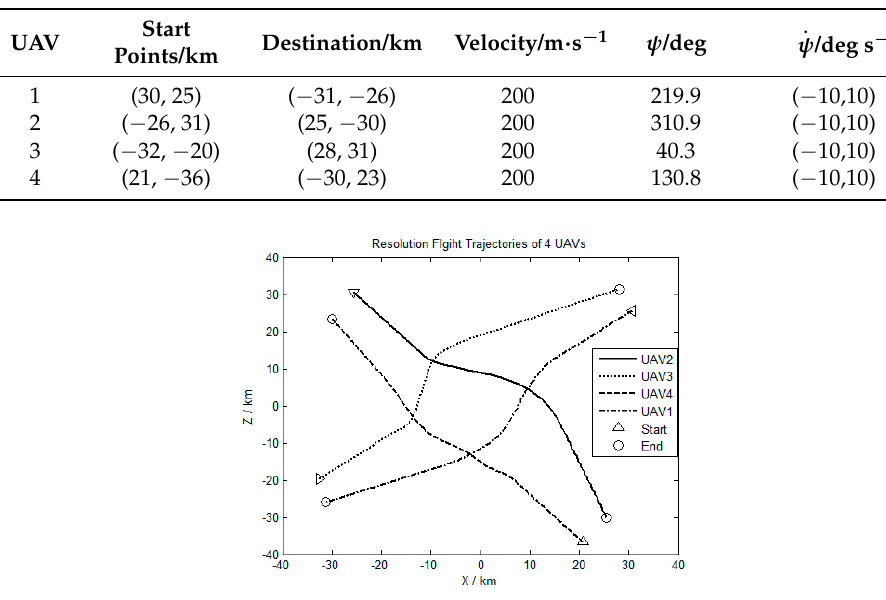
Table 2. Initial conditions and parameter values for Simulation 2.